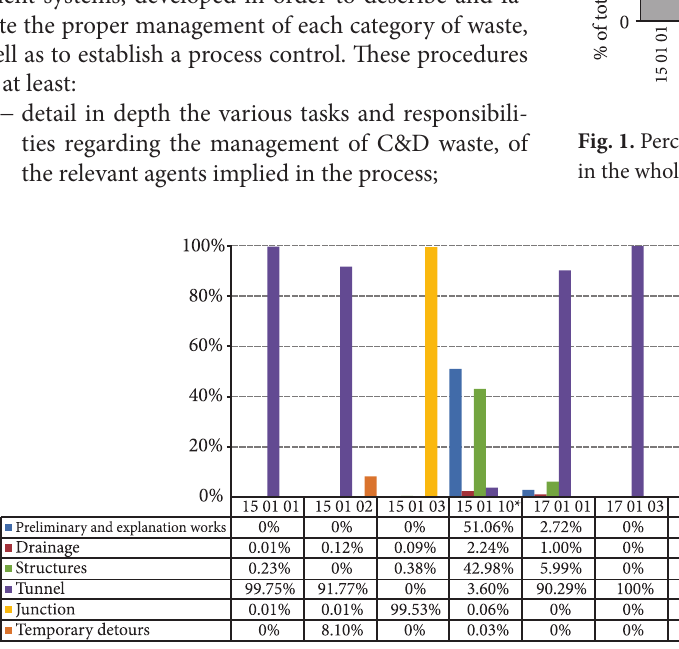
Fig. 2. Percentage of each C&D waste category generated in each construction